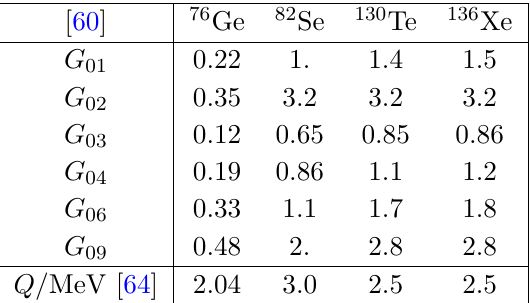
Table 4 . Phase space factors in units of 10 (cid:0) 14 yr (cid:0) 1 taken from ref. [60]. More details are given